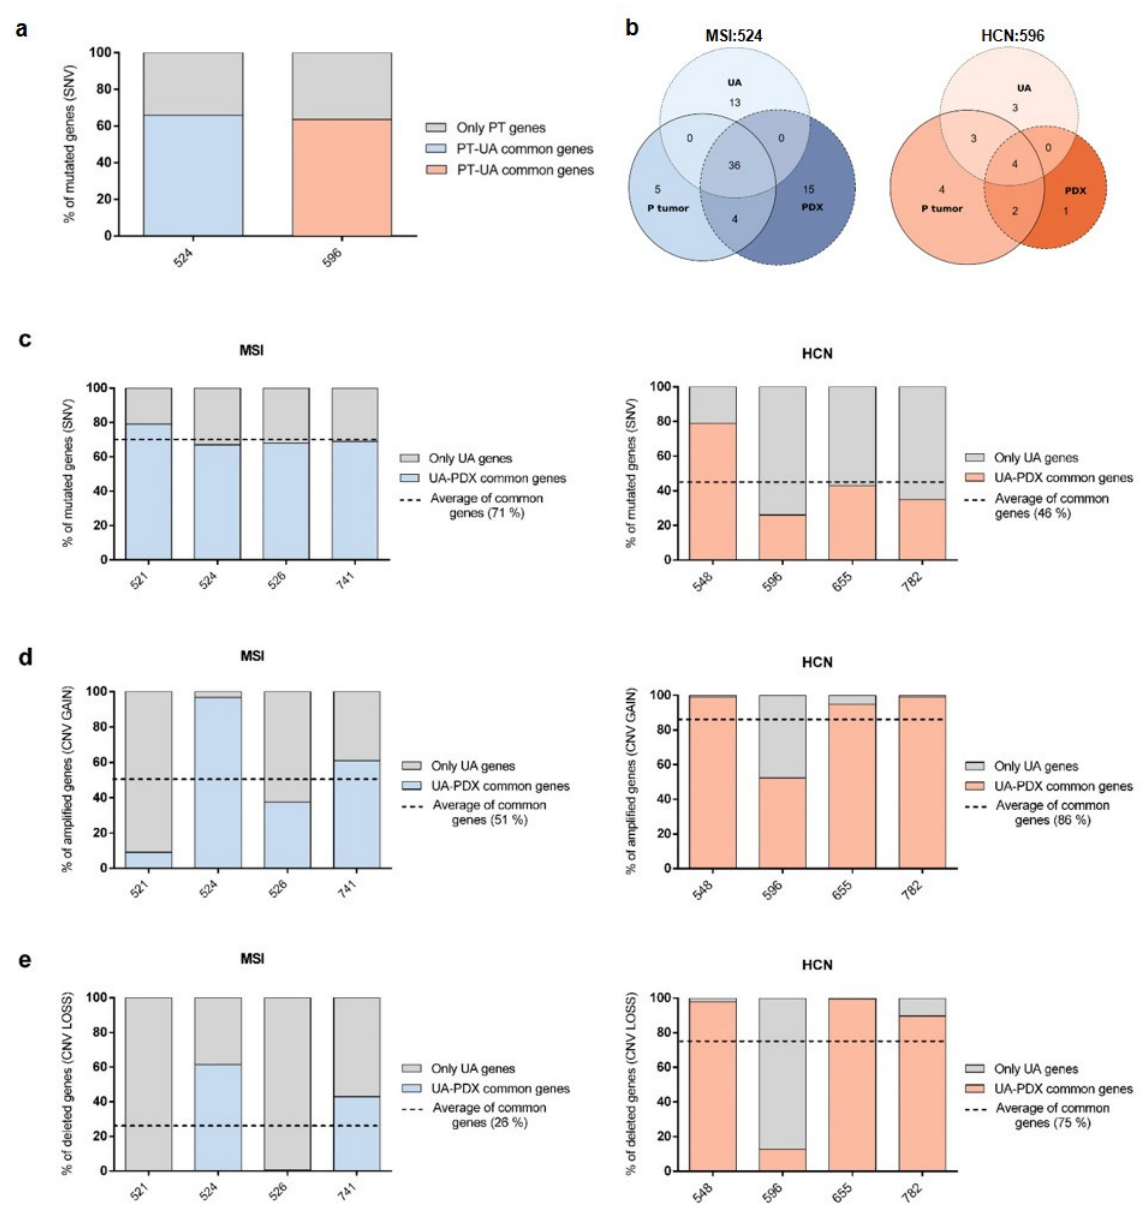
Figure 4. Molecular comparative analysis between PDXs and their EC patient counterparts. ( a ) Percentage of common genes carrying SNVs between primary tumor (PT) and UA samples from two representative EC patients, endometrioid/MSI (patient 524, blue-grey), and serous/HCN (patient 596, orange-grey). Colored bars represent the percentage of common genes between samples (PT vs. UA, blue: MSI:524; orange: HCN:596), while grey bars show the unique SNV genes present solely in the PT sample. ( b ) Venn diagram representation of the tumor driver genes found altered in MSI:524 ( left panel ) and HCN:596 ( right panel ) patient samples (PT and UA) and PDX tumor. The number of specific or shared genes is shown for each type of comparison. ( c ) Bar-plots showing the percentage of common mutated genes carrying SNVs for each PDX model compared to UA samples. ( d , e ) Comparison of the percentage of genes associated with CNV GAIN ( d ) or LOSS ( e ) events in PDX tumor vs. UA samples. Colored bars (MSI, blue; HCN, orange) represent the percentage of common genes between the PDX tumor sample and the corresponding patient’s UA, while grey bars show the unique SNV/CNV genes present only in the UA sample. Dotted lines represent the mean value of the common genes identified for each comparison.